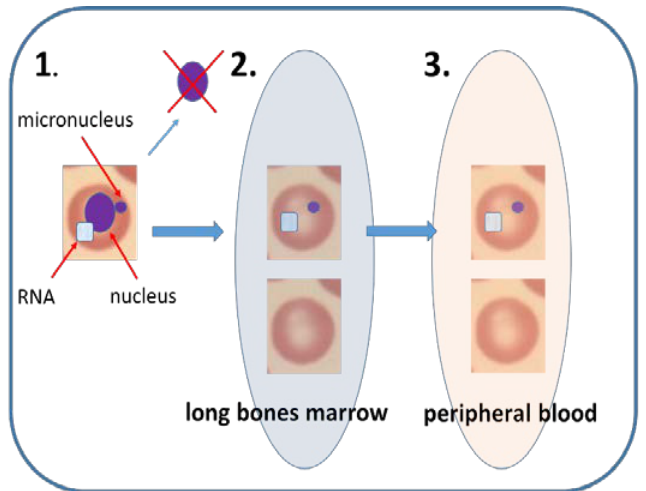
Figure 2. Mammalian erythrocyte micronucleus assay. (1). Immature erythrocyte in bone marrow contains nucleus and RNA in its cytoplasm. When DNA damage is induced in vivo, micronucleus can arise in the nucleated erythrocyte. When nucleus is excluded during erythrocyte maturation the micronucleus stays in the cytoplasm. (2). In bone marrow, immature erythrocytes consist of around 50% of all erythrocytes. Occasionally these immature erythrocytes may contain Mn. (3). Sometimes the immature erythrocytes are released to peripheral blood, where they constitute less than 5% of all erythrocytes. The immature erythrocytes in blood can be recognized due to their specific surface receptors or RNA content. Flow cytometry technique makes the EMn feasible in peripheral blood of rodents and humans.